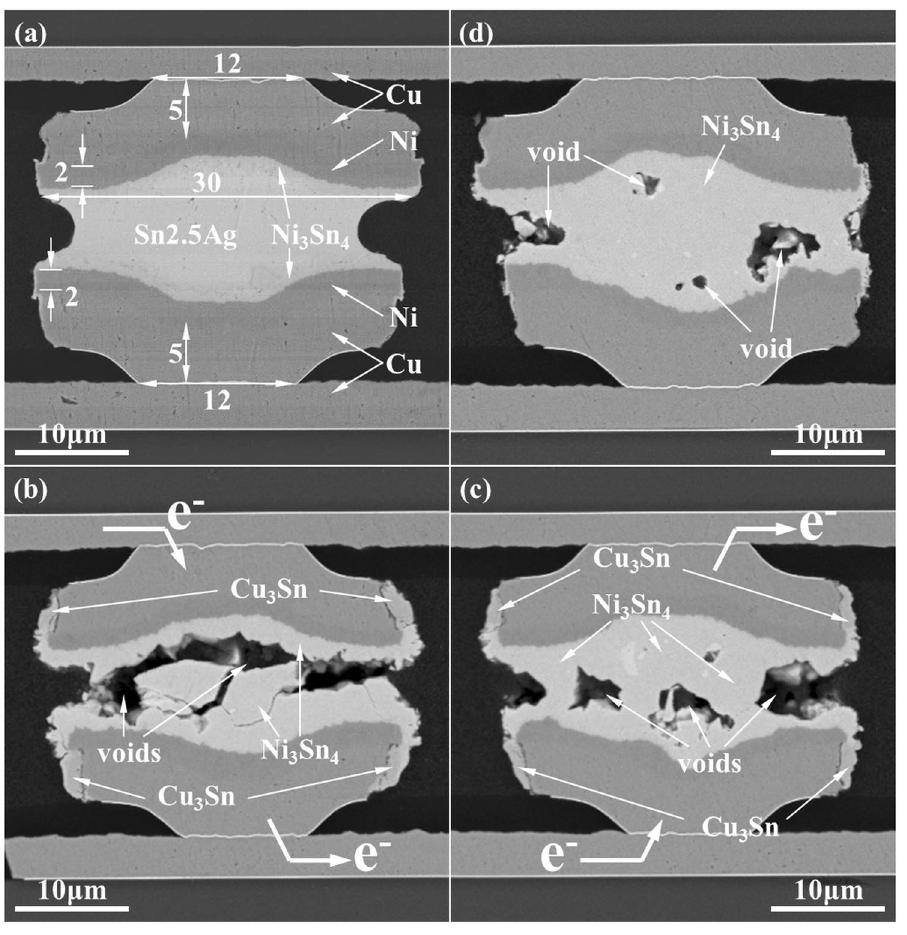
Figure 4. ( a ) The SEM image of the as-prepared microbump with 30 µ m in diameter; ( b ) and ( c ) the SEM image of microbumps showing severe void formation or necking after the EM test by 4.0 × 10 4 A/cm 2 at 150 °C for 2320 h; ( d ) the SEM image of the dummy microbump with the same thermal history as the stressed